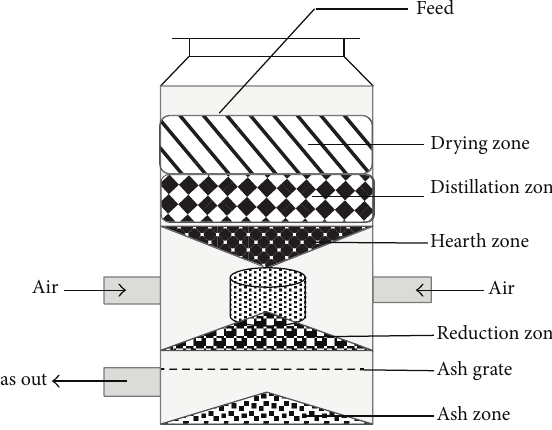
Figure1:Fixed-beddowndraftgasifierorcocurrentgasifier[Adopt- ed from FAO Corporate Document Repository, 1986]